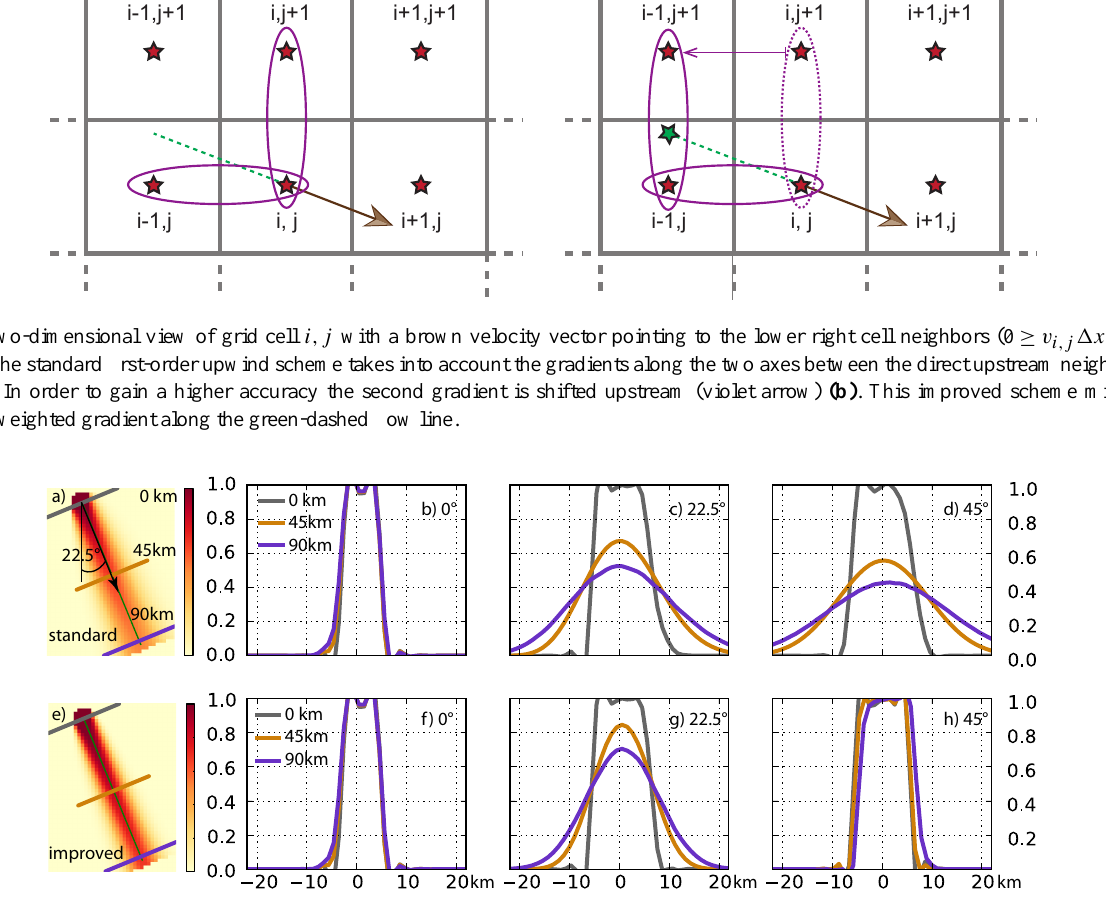
Fig. 4. Dissipation of fracture density during transport as studied in a simplified ice-shelf setup where the main flow direction is 0 ◦ , 22.5 ◦ and 45 ◦ and oblique with respect to the underlying regular grid of mesh width 2km. The fracture band originates in a small spot with maximal fracture density φ = 1. Results shown in the top-panels are produced with the standard first-order upstream transport scheme, in the lower panels with the improved scheme. The steady-state cross-profile of the fracture band is compared at three transects perpendicular to the main flow direction at the source (grey), as well as with 45km (brown) and 90km (violet) distance, using bivariate interpolation for the